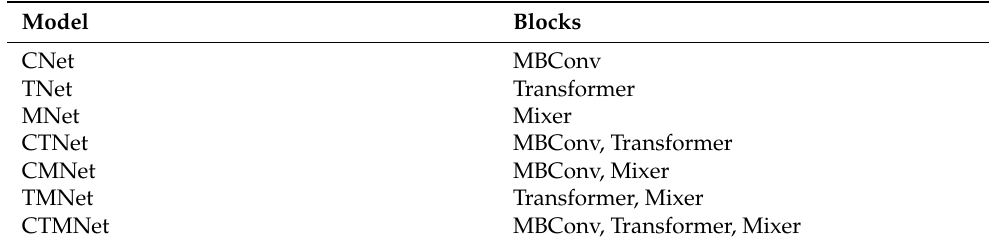
Table 1. 7 hybrid models of different combinations in this study.